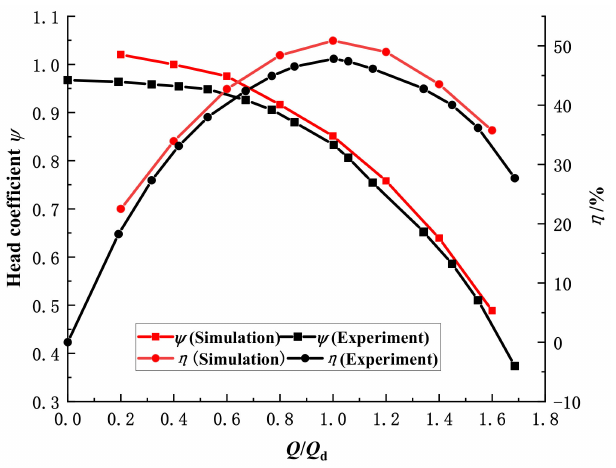
Figure 6. Comparison of pump performance between numerical and experimental